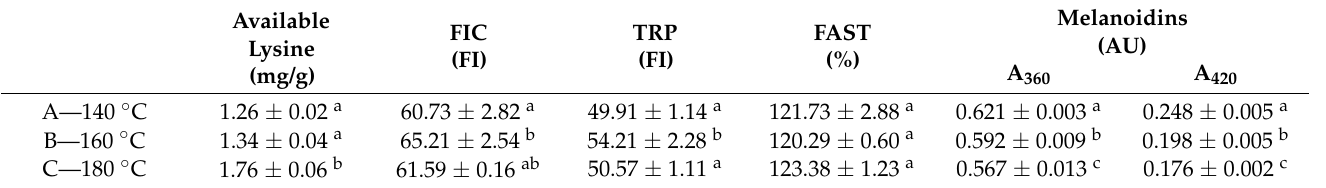
Table 3. The effect of spray-drying conditions on the early, advanced and final stages of Maillard reactions.